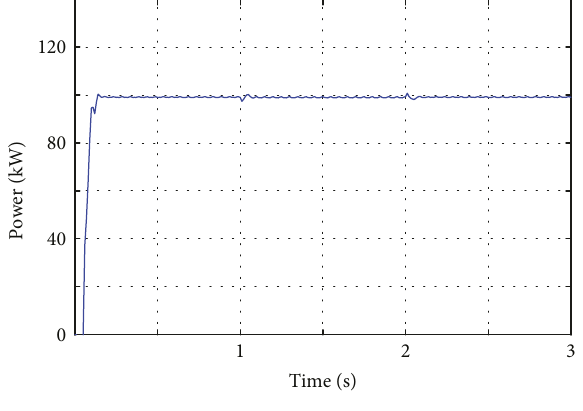
Figure 13: Power invariance.